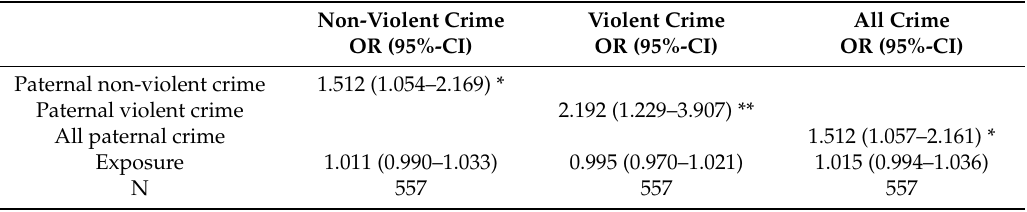
Table 2. Logistic regression models predicting offspring criminal